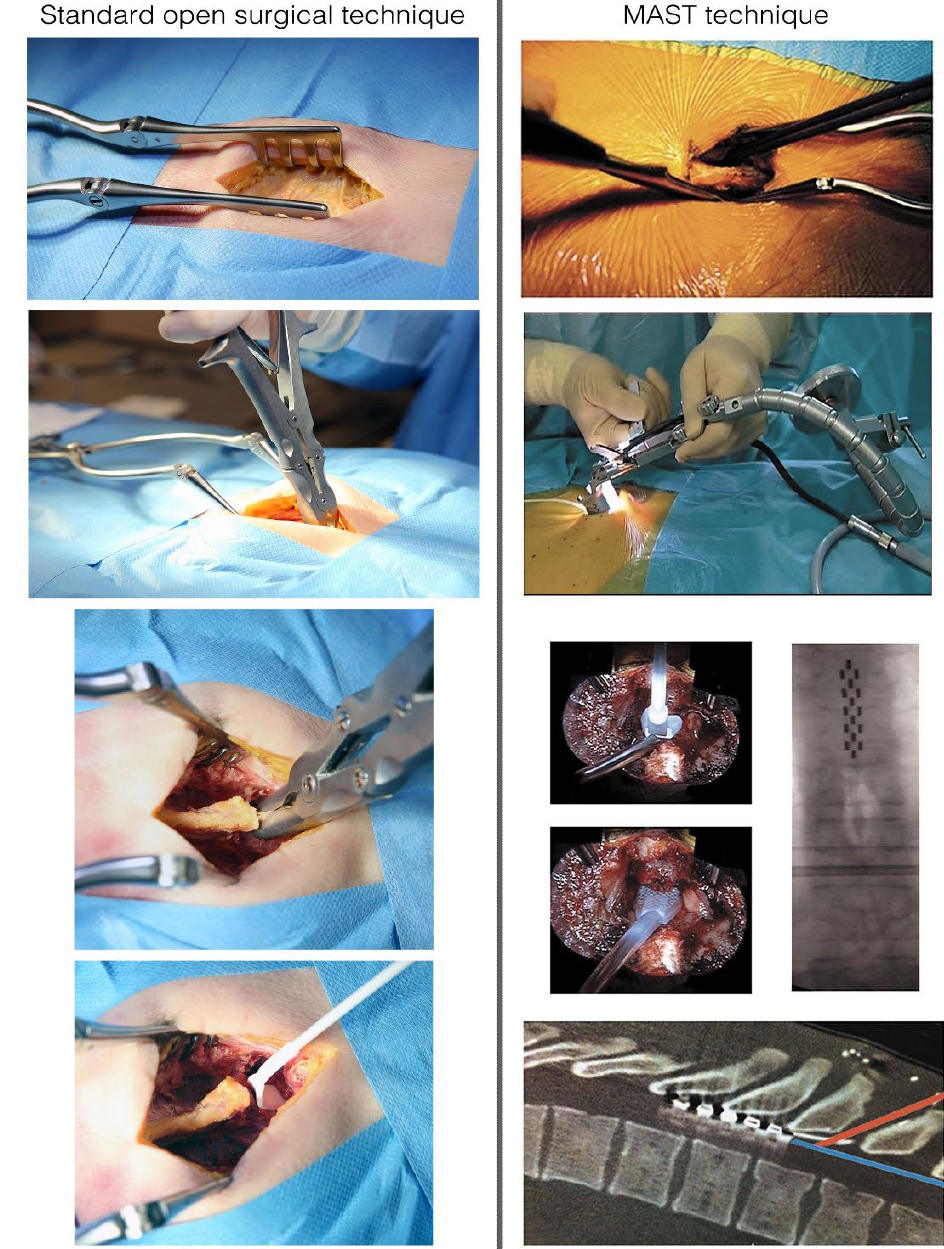
Figure 1. Conventional surgical approach ( Left ). The surgical approach consists in separating paraspinal fascia and muscles from the spinous process and ligaments. Once the spinous process and laminae have been exposed, removal of the supraspinous, the interspinous ligament and the ligamentum flavum is possible thanks to a small gouge or an arthrectomy pinch. Kerrison rongeurs can be used to remove a small portion of the inferior lamina of the upper vertebra to place the lead phantom and then the paddle lead in the epidural space. Aspects of the minimally invasive (MAST) procedure ( Right ). The surgical approach on one or both sides of the supraspinous process, with careful dissection of the paravertebral musculature. Full system set. Insertion of the phantom lead and implantation of the lead in the median position, verified by intraoperative X-ray. The aspects of lead implantation angle: an approach at the thoracic spine level is possible by using the minimally invasive technique. The bony removal can be minimized, and a shallow, safe angle of insertion achieved with a retractor system and illumination.